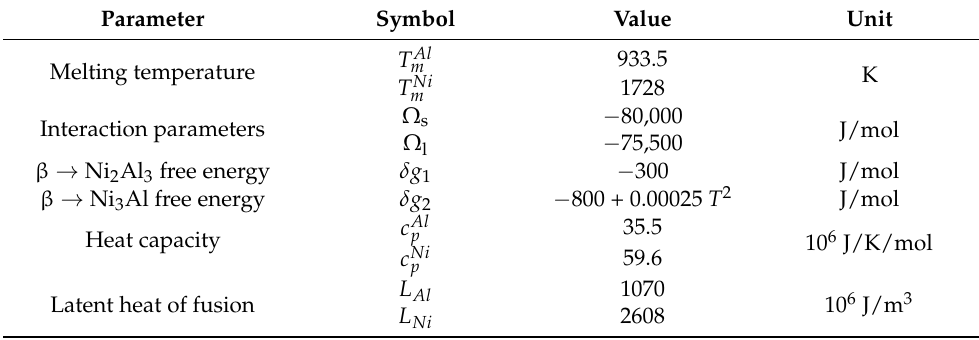
Figure 2. The calculated phase diagram for the model Ni-Al system. Table 2. Thermodynamic parameters. The latent heats of fusion are from Ref. [37], the other parameters are from Ref. [38].